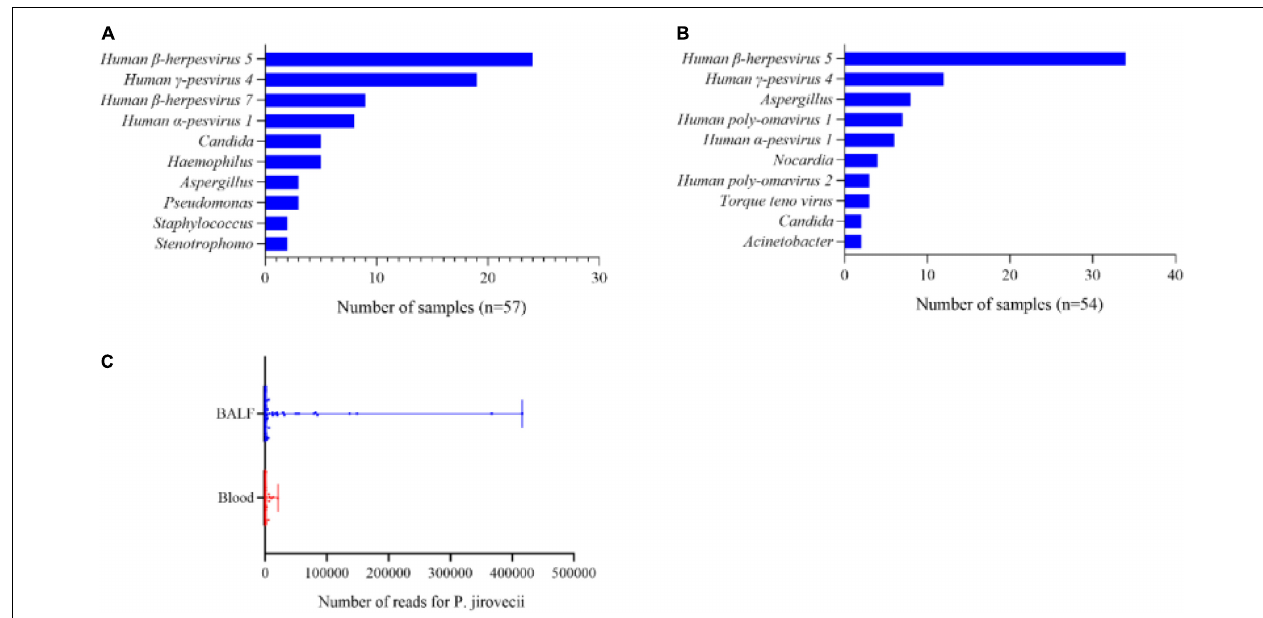
FIGURE 2 | A pathogens spectrum in different samples of the patients with PJP. (A) Co-pathogens in BALF samples. (B) Co-pathogens in blood samples. (C) Reads of P. jirovecii in BALF and blood samples. The median reads in BALF were significantly higher than that in the blood samples (990.5 vs. 73, p < 0.001).